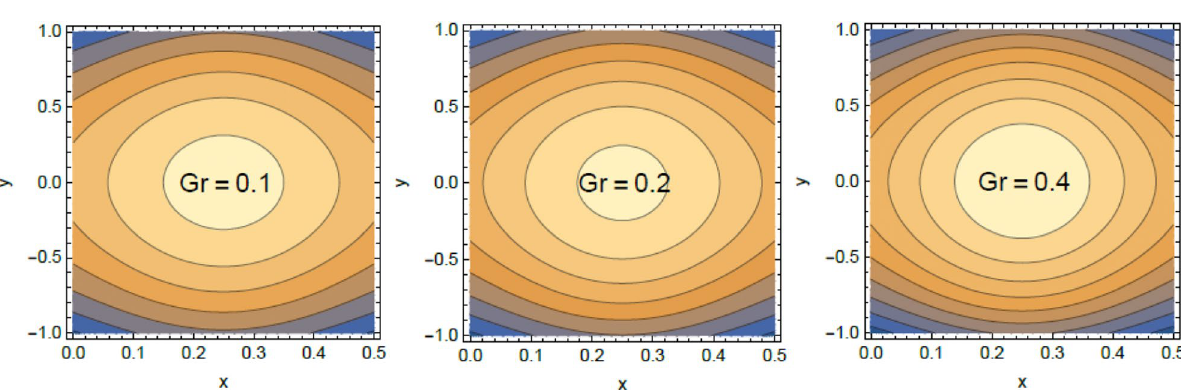
Figure 22. Contour plot of the speed for various amounts of the pseudo plastic factor α .